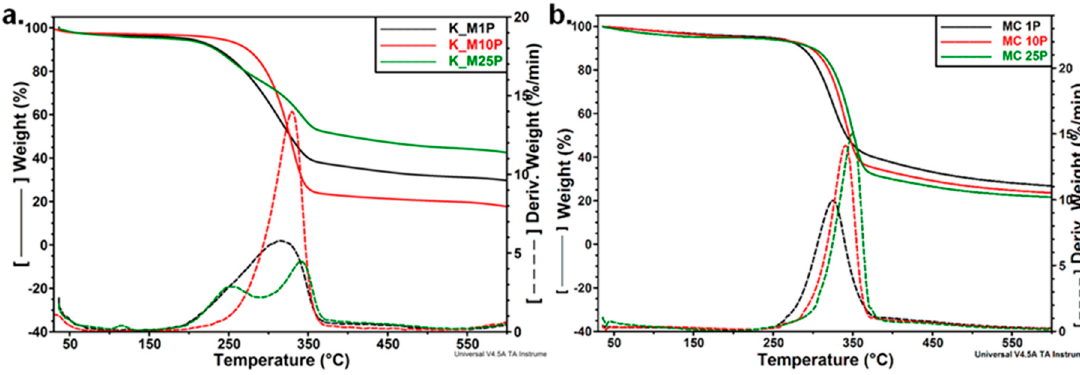
Figure 12. Influence of the passes through microfluidizer on the thermal stability of Kombucha pellicles ( a ) and microcrystalline cellulose ( b ).